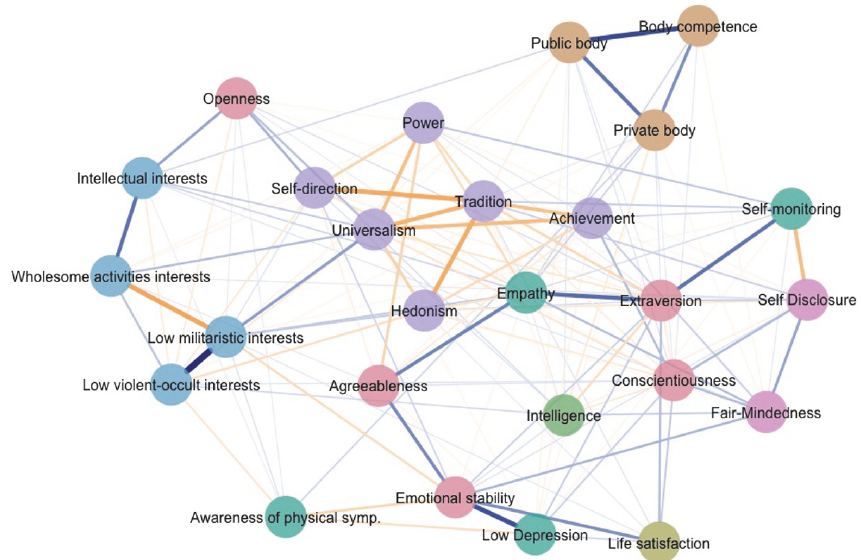
Figure 1: Nonregularized partial correlation network (set N = 4131, true N =1066921, layout spring, cut = 0). Blue ties signify positive relations and orange ties signify negative relations. The thickness of a tie is proportional to its absolute weight.